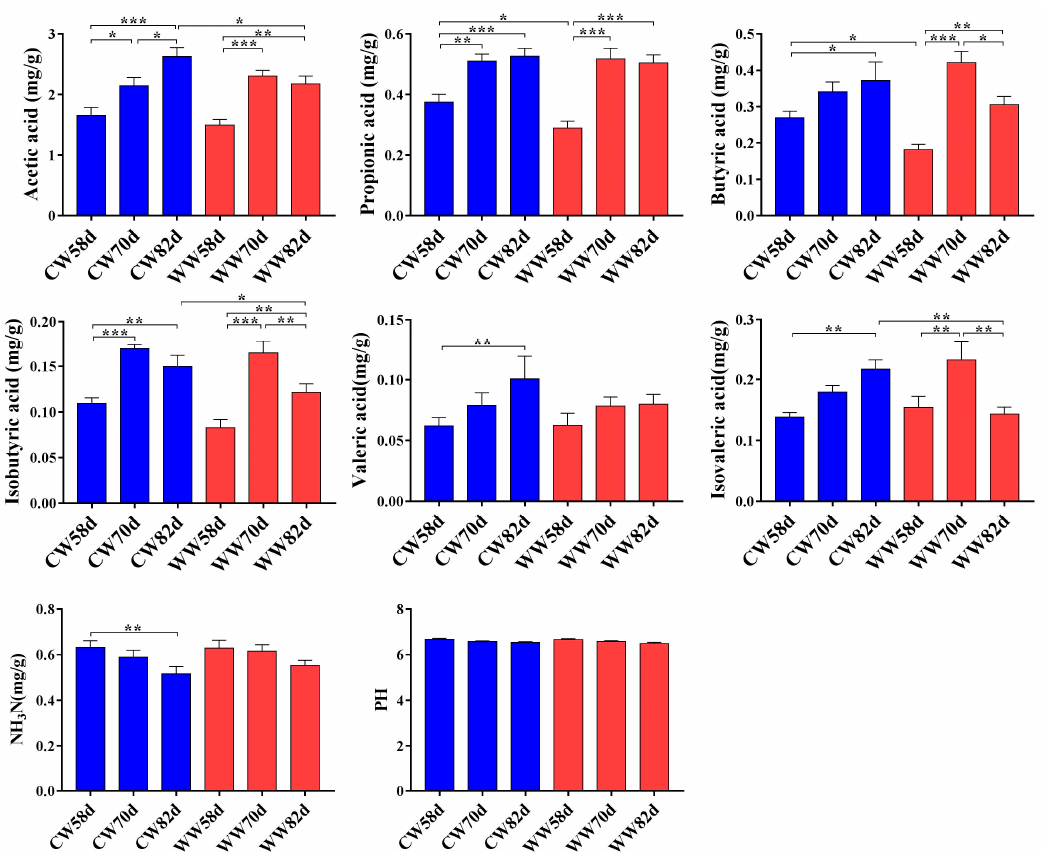
Figure 3. Effects of drinking warm water on short-chain fatty acids (SCFAs) concentration, NH 3 -N concentration, and pH values of rabbits ( n = 8). CW, cold water group; WW, warm water group. * p < 0.05, ** p < 0.01, *** p < 0.001. Values are shown as means ± SEM. Differences were analyzed by one-way analysis of variance followed by the least-significant difference post hoc test.